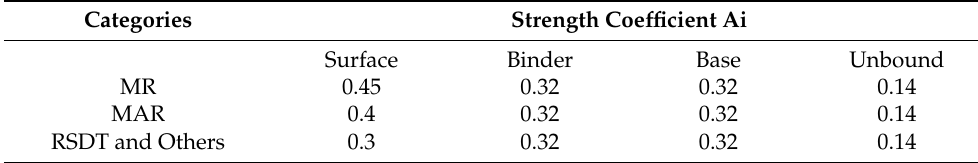
Table 8. Strength coefficient * used to calculate the structural number.